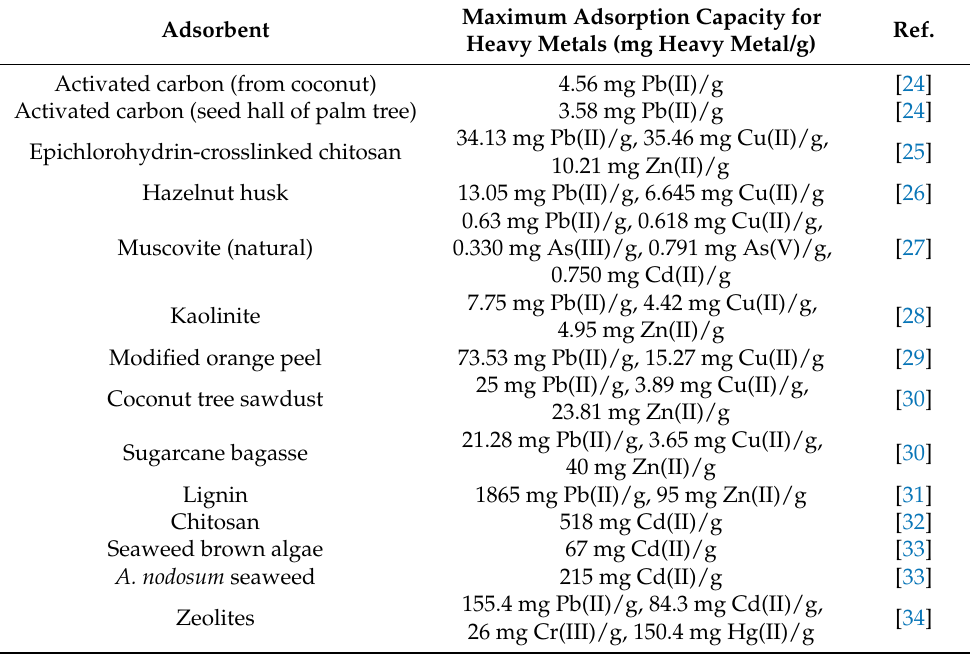
Table 2. Maximum adsorption capacity of other low-cost